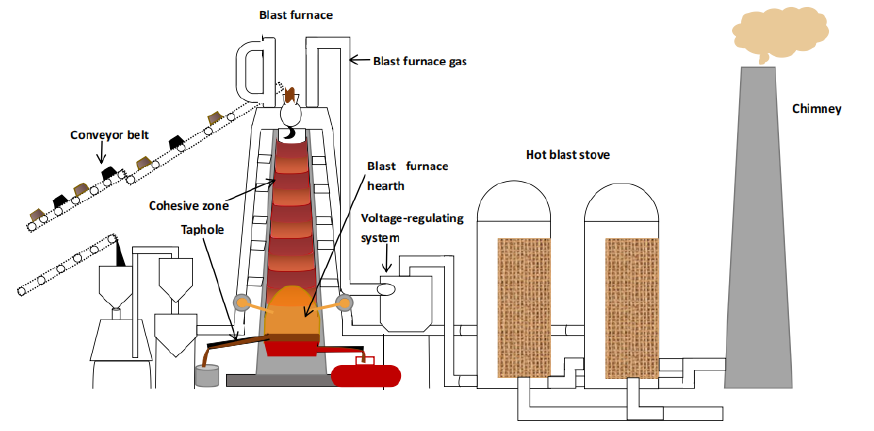
Figure 6. 3D virtual reality digital twin system interface of the iron blast. The main element of the large-scale blast furnace digital twin system has been